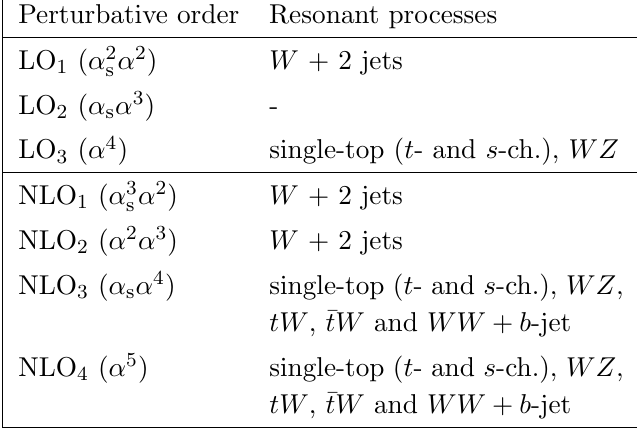
Table 1 . Intermediate resonances contributing to the various perturbative orders that enter the